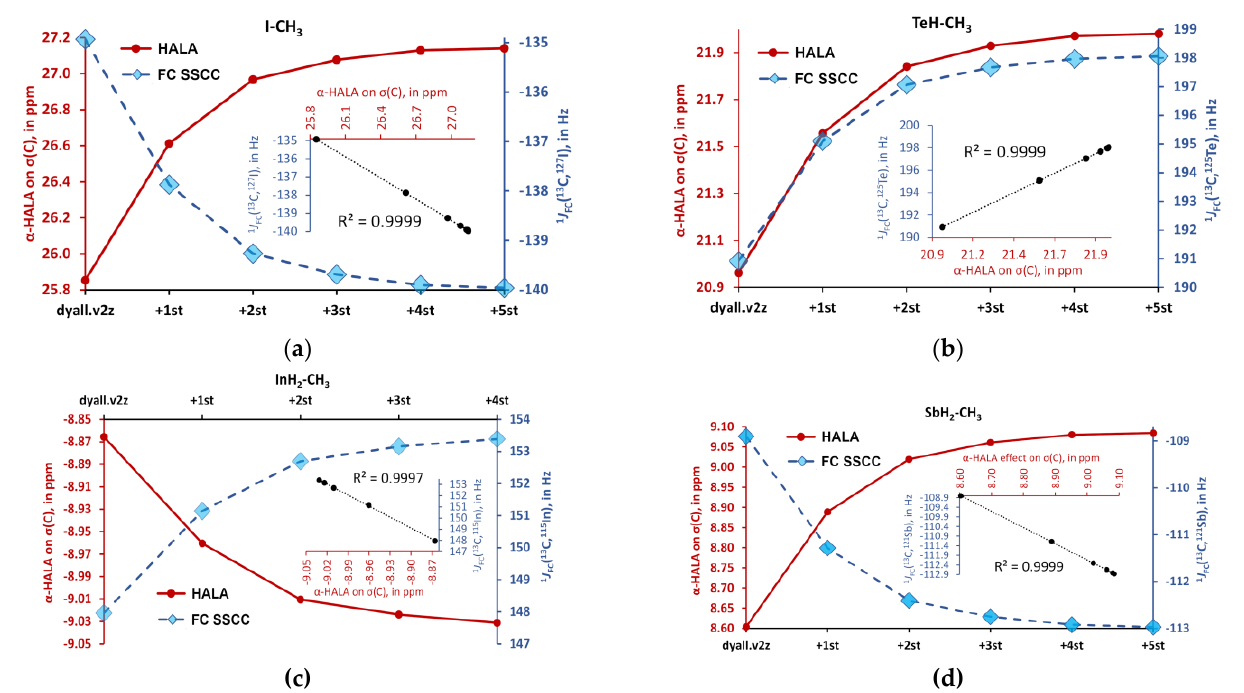
Figure 9. The behaviors of the α -HALA effects on σ ( 13 C) upon the saturation of the dyall.v2z basis set on carbons in the tight s -region against that of the 1 J FC (HA, 1 H) in molecules are: ( a ) I-CH 3 ( 2 ); ( b ) TeH-CH 3 ( 6 ); ( c ) InH 2 -CH 3 ( 4 ); and ( d ) SbH 2 -CH 3 ( 3 ).